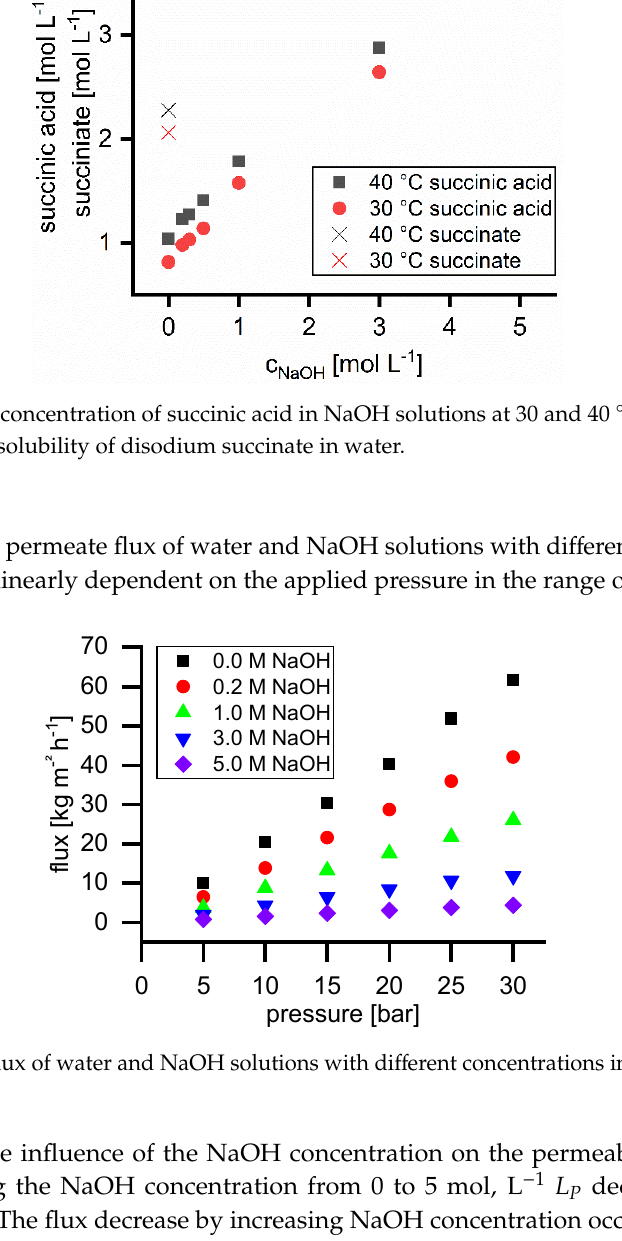
Figure 2. Permeate flux of water and NaOH solutions with different concentrations in the range from 5 to 30 bar at 40 °C.